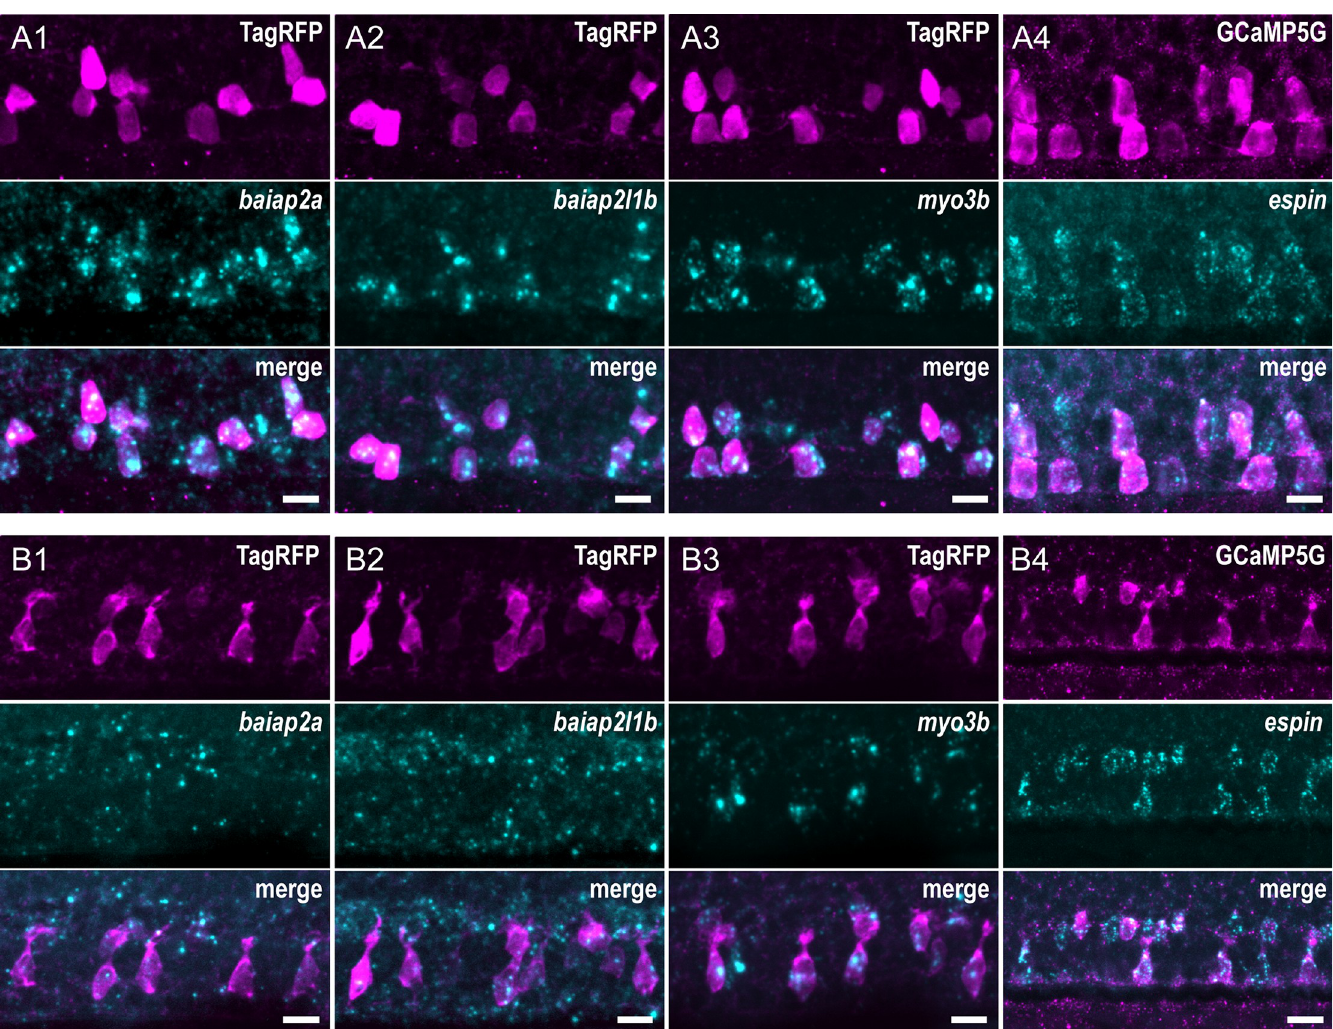
Fig 4. CSF-cNs express a set of known morphogenetic factors. Expression of candidate factors known to be involved in the formation of actin-based protrusions— baiap2a , baiap2l1b , myo3b , and espin —assessed by FISH at 24 hpf (A1–4) and 72 hpf (B1–4). Expression in CSF-cNs was validated by combining FISH to IHC for RFP or GFP in Tg(pkd2l1 : TagRFP) (A1–3, B1–3) or Tg(pkd2l1 : GCaMP5G) (A4, B4) transgenic animals, respectively. In 24-hpf embryos, baipa2a (A1), baiap2l1b (A2), myo3b (A3), and espin (A4) were enriched in CSF-cNs. In 72-hpf larvae, expression of baiap2a (B1) and baiap2l1b (B2) was not clearly detected, whereas myo3b (B3) and espin (B4) remained strongly expressed in CSF-cNs. Scale bars, 10 μ m. CSF-cN, cerebrospinal fluid-contacting neuron; FISH, fluorescent in situ hybridization; GFP, green fluorescent protein; hpf, hours post fertilization; IHC, immunohistochemistry; RFP, red fluorescent